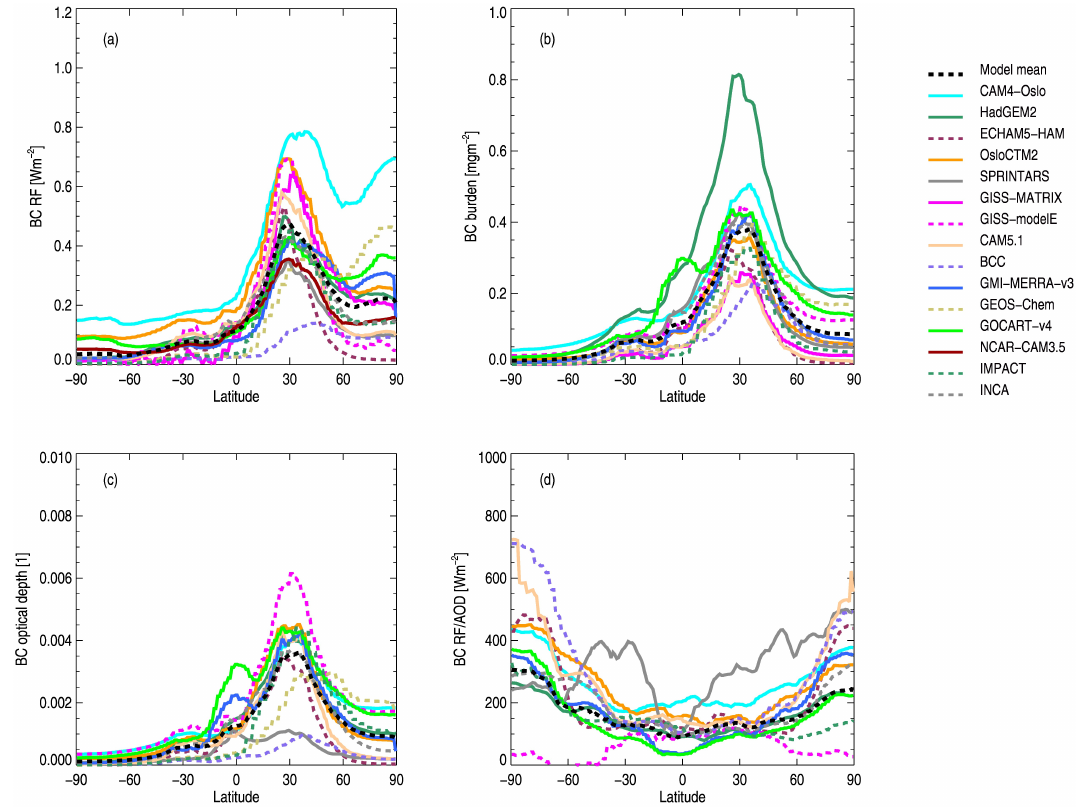
Fig. 9. Zonal mean BC RF (a) , burden (b) , AOD at 550nm (c) , NRF(A) (d)